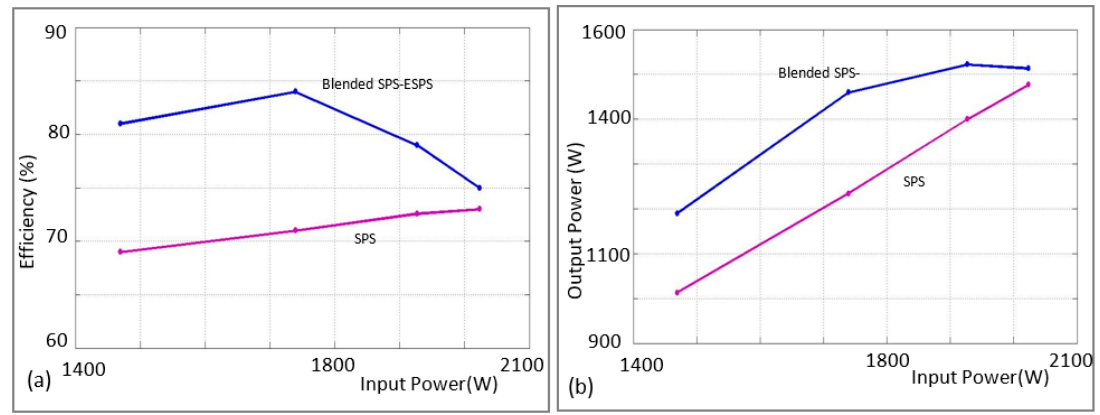
Figure 15. Blended SPS-ESPS control DAB-IBDC Power conversion efficiency. ( a ) Input Power vs Efficiency, ( b ) Input Power vs Output Power.